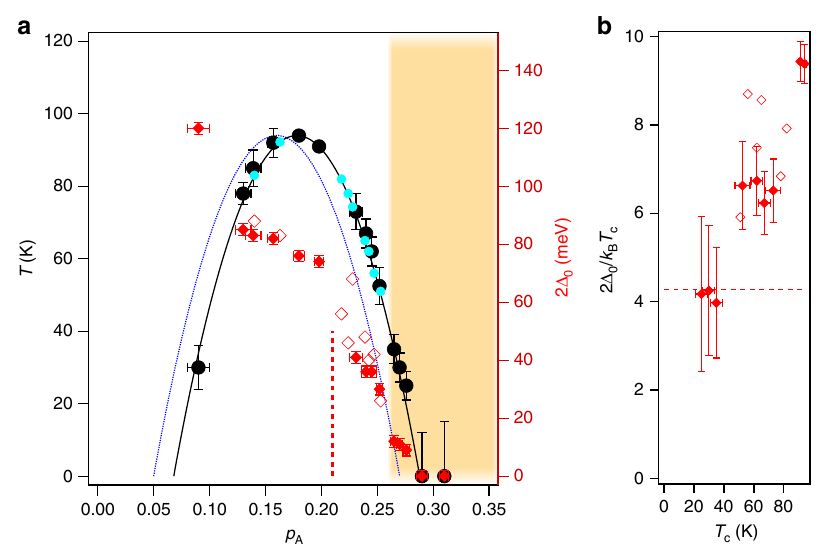
Fig. 3 Phase diagram of Bi 2 Sr 2 CaCu 2 O 8 + δ . a Experimentally obtained superconducting transition temperature, T c , (black circles) and the antinodal gap, 2 Δ 0 (solid red diamonds) are plotted versus experimentally determined doping parameter, p A . Also shown are gap values (open red diamonds) and T c (turquoise circles) for different doping levels from several previously published studies 5,31,32,34 . These points are placed at the corresponding p A in accordance with our new T c ( p A ) dependence. The universal superconducting dome is shown as blue dashed line, while the corrected dome is represented by black solid line. The red dashed line indicates the transition observed in SI-STM studies 9 . The shaded area marks the region that has not been studied before. Characteristic temperatures are displayed against the left axis, while the right axis is for the spectral gap. b Ratio of the antinodal gap and T c for the points shown in a from the overdoped side. The red dashed line corresponds to the BCS value for d -wave gap. We have approximated the uncertainty in doping, Δ p A , (horizontal error bars in a ) to be proportional to the width of the Fermi surface: Δ p A / p A ~ 2 Δ k F / k F . The uncertainty in T c is given by the width of superconducting transition in susceptibility measurements (underdoped samples), or by the temperature step size in T -dependent ARPES measurements that identify T c (overdoped samples). The uncertainty in gap magnitude (red vertical error bars in a ) corresponds to the standard deviation of the quasiparticle peak position determined from fi tting. It serves to determine the propagated uncertainty (vertical error bars) in